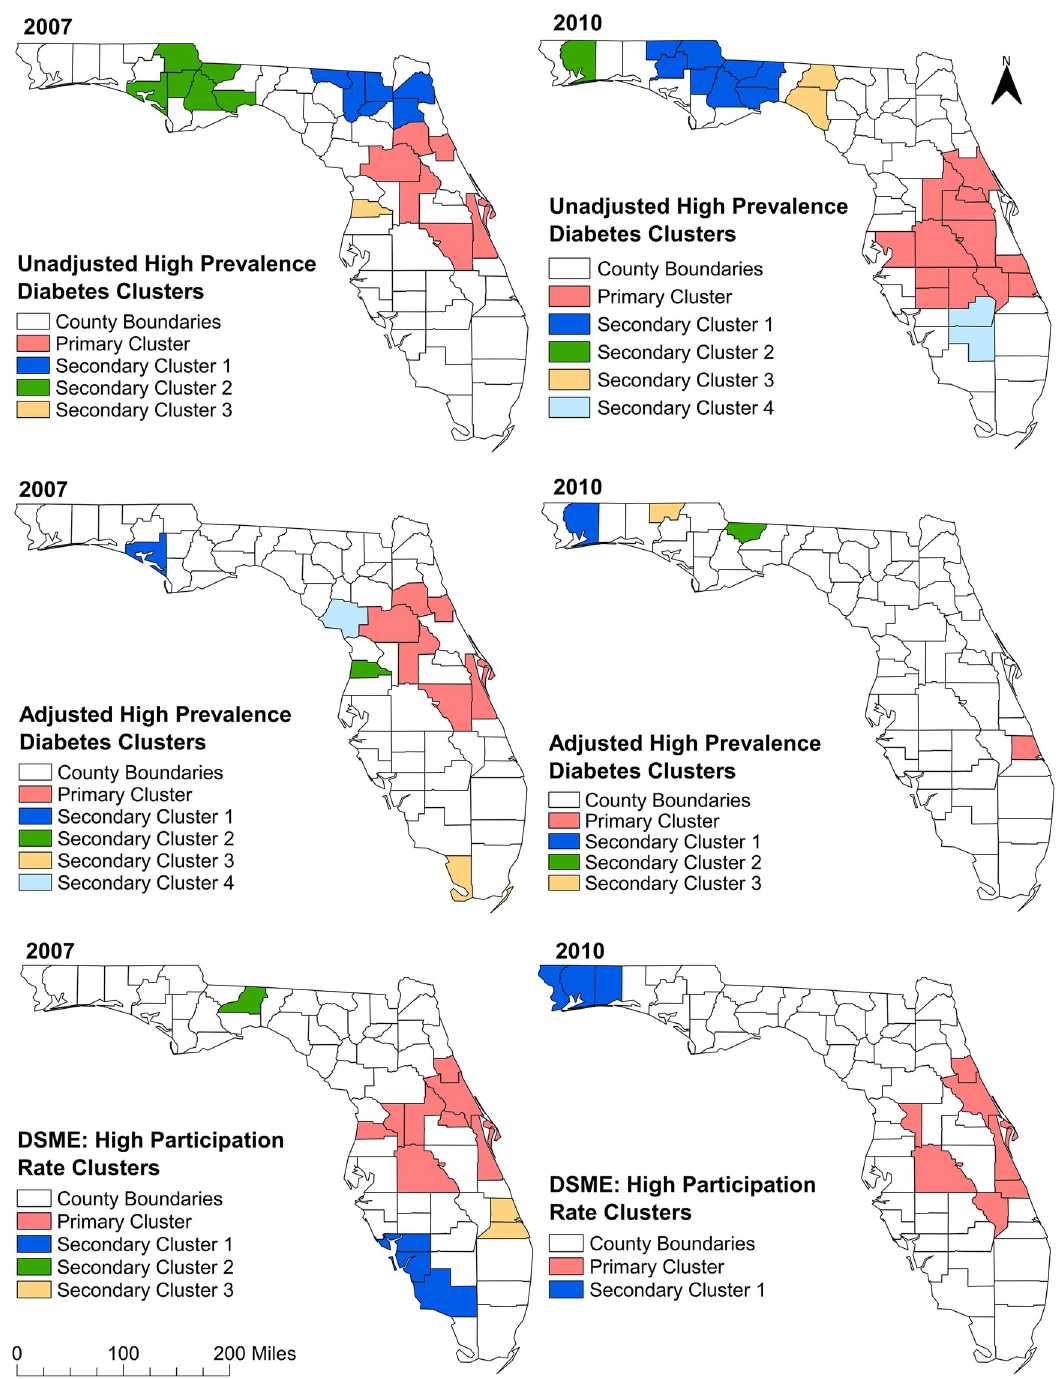
Fig 4. Clusters of high diabetes prevalence and high diabetes self-management education program participation rates identified in Florida using Tango’s flexible spatial scan statistics, 2007 and 2010. Figure was created using the Free and Open Source Geographic Information System (GIS) software, QGIS. The basemaps used to create the maps were downloaded from the US Census Bureau Website: https://www.census.gov/geographies/mapping-files/time-series/geo/tiger-line-file.2010.html. The diabetes prevalence and diabetes self-management education (DSME) participation rate data were obtained from Florida Department of Health Website. These data are available at: http://www.flhealthcharts.com/charts/Brfss/DataViewer.aspx?bid=21 (prevalence data) and http://www.flhealthcharts.com/charts/Brfss/DataViewer.aspx?bid=51 (DSME data).